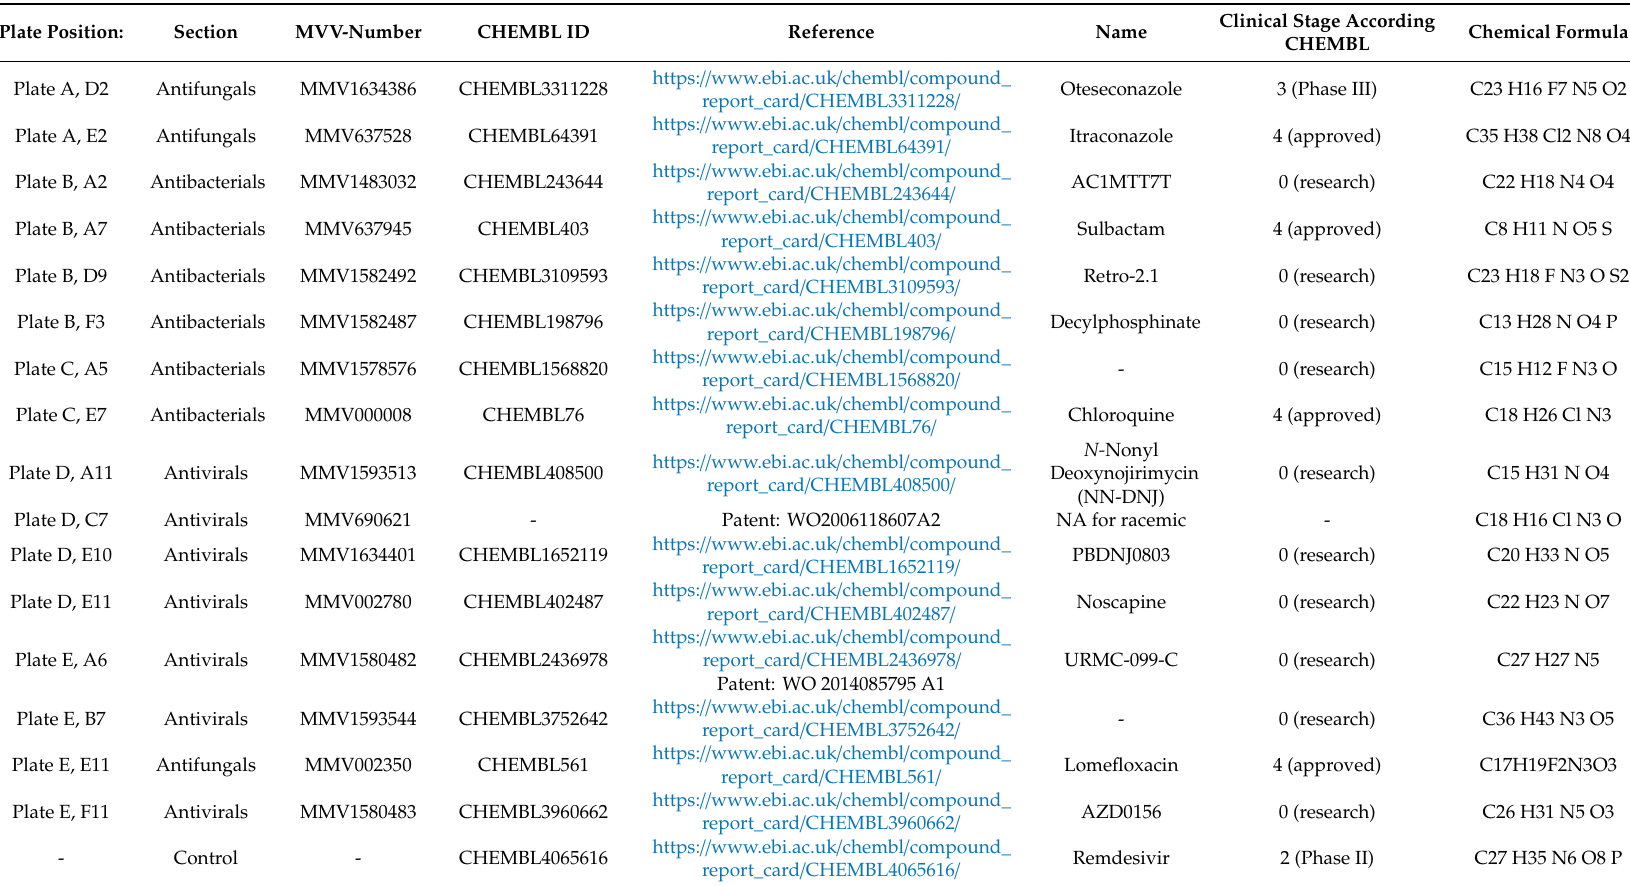
Table A1. The sixteen compounds that showed inhibition of SARS-CoV-2 after the survival screen. Remdesivir was included as a reference drug